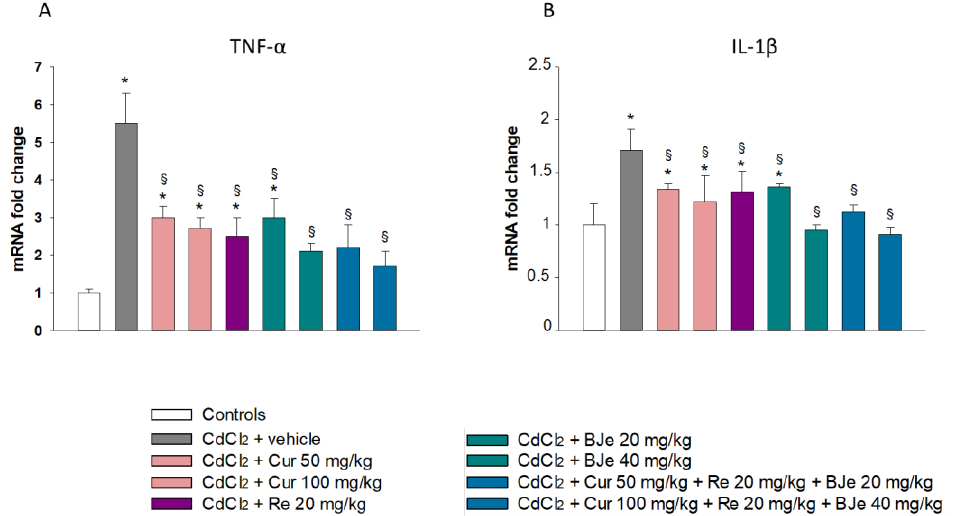
Figure 1. Real-time PCR analysis for TNF-α ( A ) and IL-1β ( B ). * p < 0.05 versus control mice; § p < 0.05 versus CdCl2-treated mice.